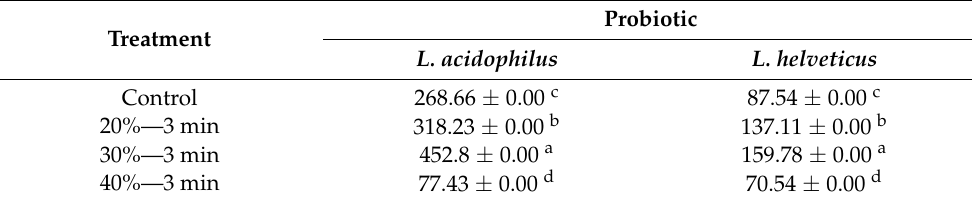
Table 2. Effect of ultrasound (20 kHz) on the β -galactosidase (U) of L. acidophilus and L. helveticus .